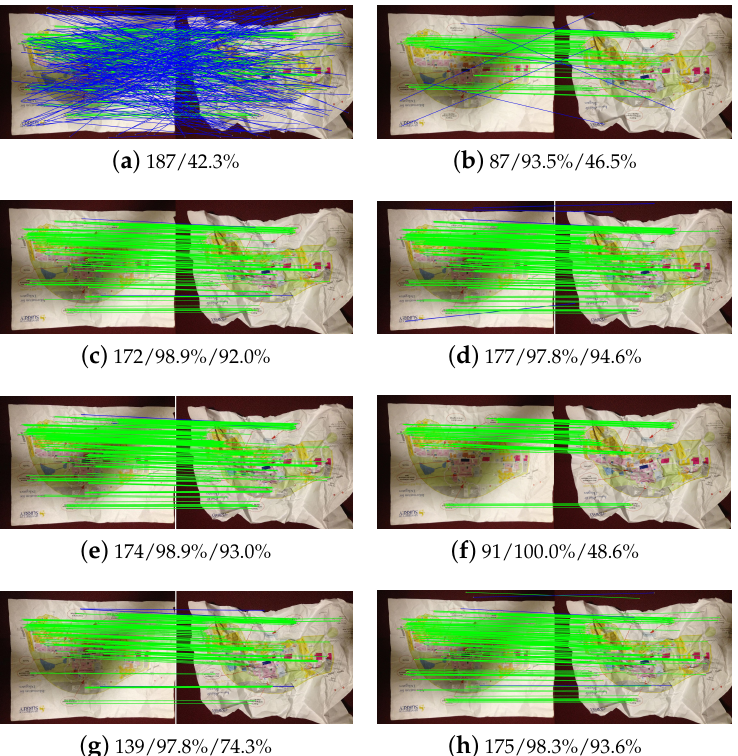
Figure 19. Matching results of image pair 2 in the non-rigid dataset: ( a ) initial matches; ( b ) RANSAC;